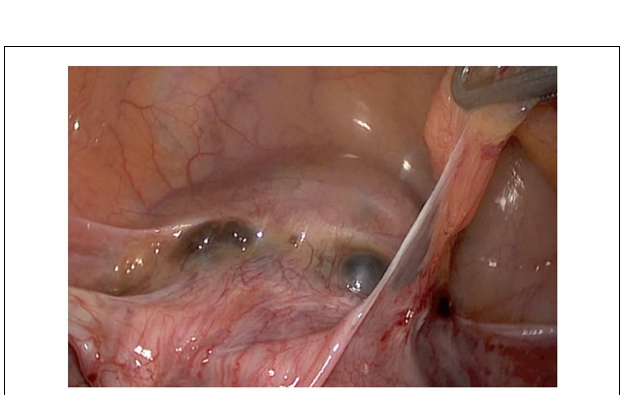
FIGURE 1 | (A) Intra-uterine pregnancy at 7weeks of gestation, with trophoblastic insertion in the cesarean scar site, with a Doppler flow underneath. (B) Distended uterine scar after D&C.